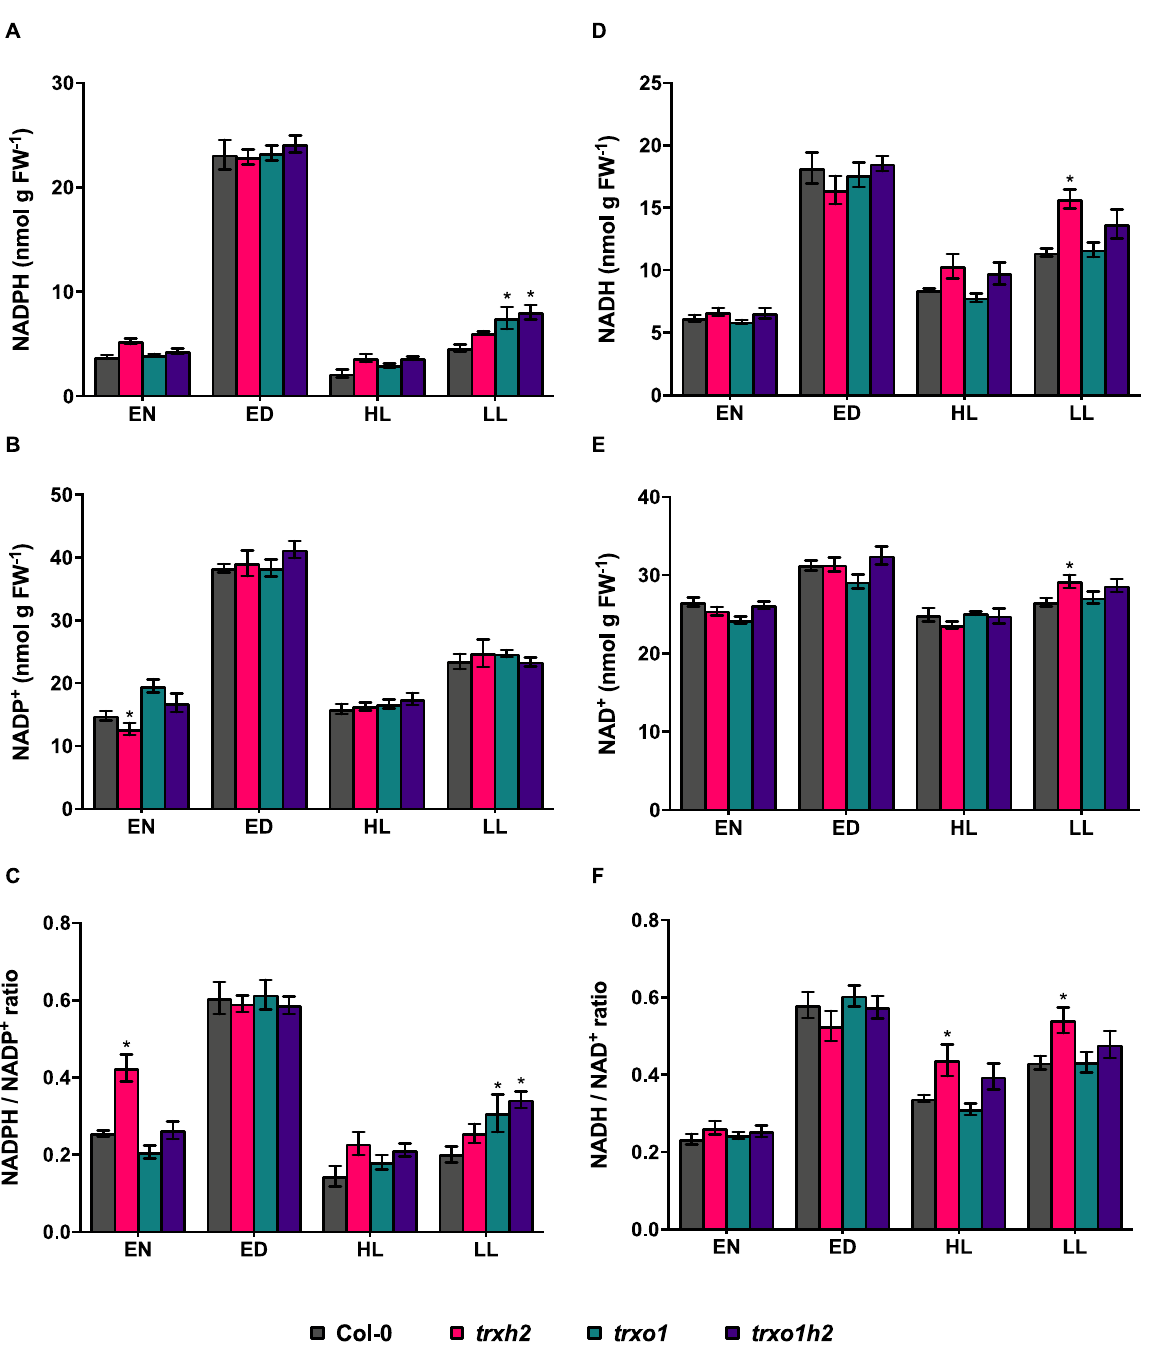
Figure 7. The redox couples of NADP(H) and NAD(H) in the wild type (Col-0) and the mutant lines ( trxh2 , trxo1 and trxo1h2 ). Arabidopsis plants grown under medium light conditions were harvested at the end of the night (EN) and the end of the day (ED), respectively. Arabidopsis grown under fluctuating light conditions were harvested at the high-light phases (HL) and low-light phases (LL), respectively. ( A ) The level of NADPH. ( B ) The level of NADP + . ( C ) The NADPH-to-NADP + ratio. ( D ) The level of NADH. ( E ) The level of NAD + . ( F ) The NADH-to-NAD + ratio. Mean values and standard errors derived from 6 biological replicates. The statistical analyses were performed using ANOVA and the Dunnett’s test (* p < 0.05, in comparison to the wild type).